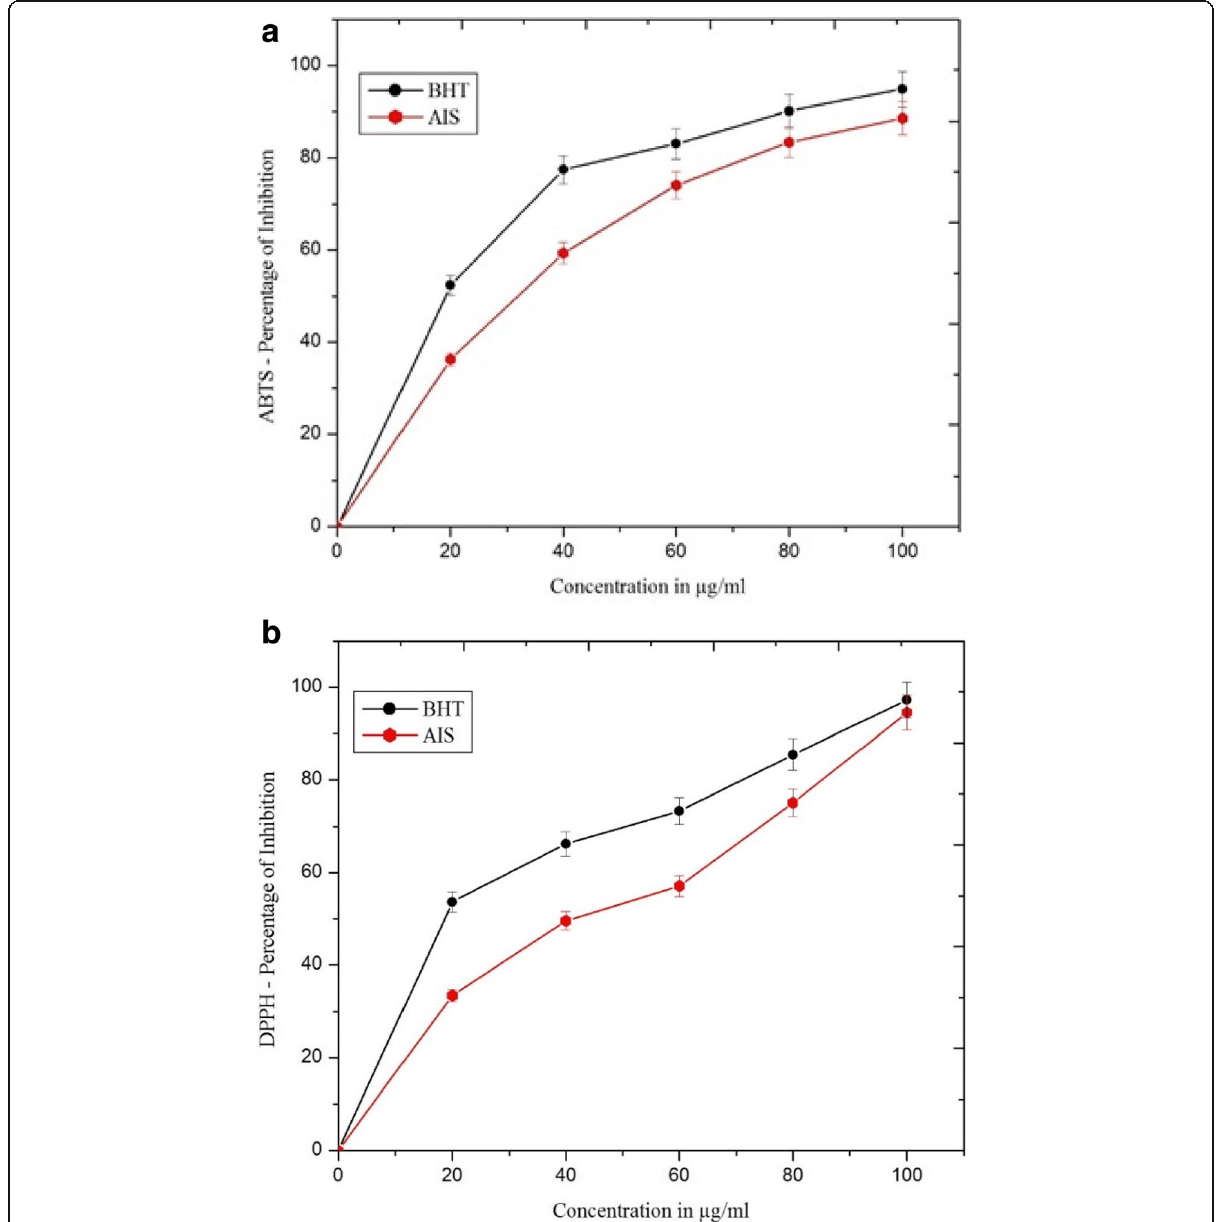
Fig. 1 a Antioxidant activity of AIS. a ABTS .+ radical scavenging activity of AIS compared with BHT. Each value is expressed as the mean ± standard deviation ( n = 3). b DPPH radical scavenging activity of AIS compared BHT. Each value is expressed as the mean ± standard deviation ( n =